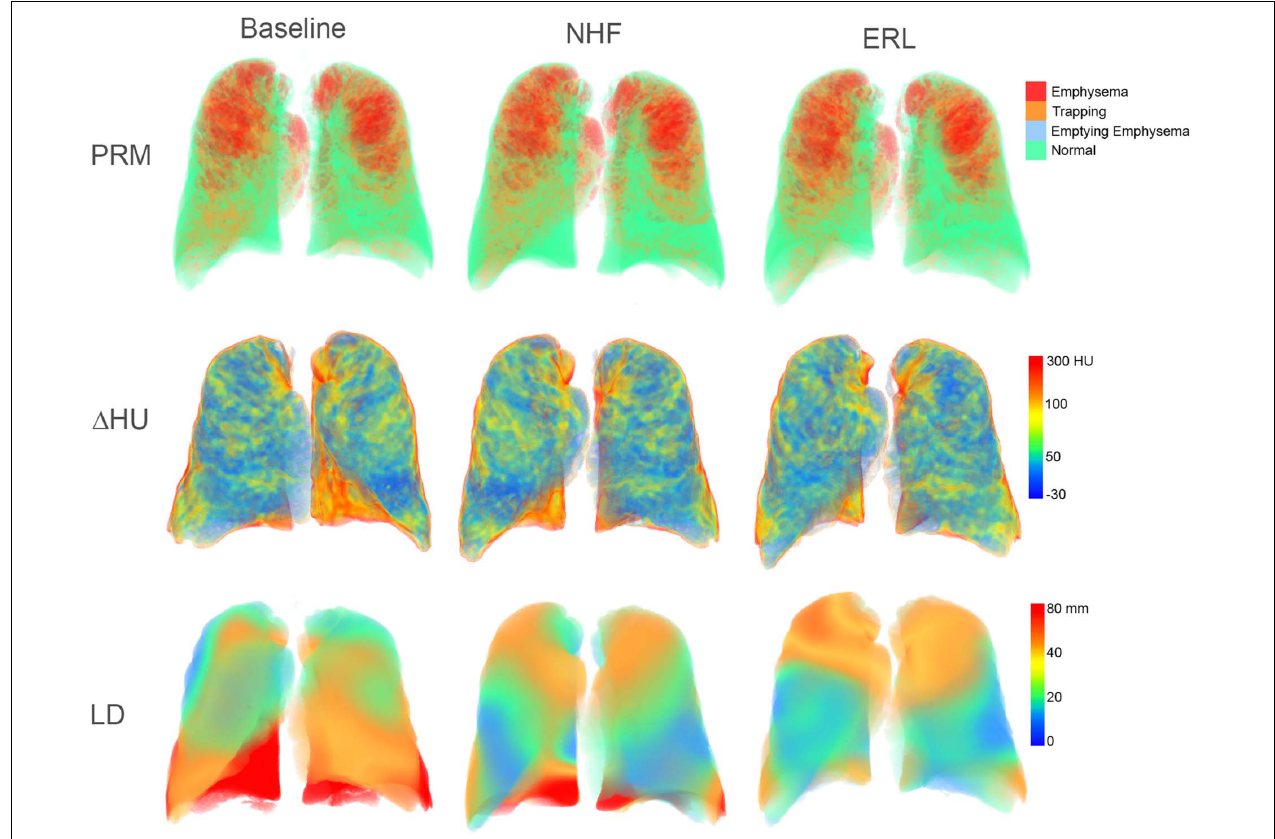
FIGURE 2 | 3D rendering of computed regional lung function indices in a sample COPD patient. PRM, parametric response maps; (cid:49) HU, regional attenuation changes from maximal expiration to maximal inspiration; LD, lung displacement; NHF, nasal high flow; and ERL, expiratory resistive